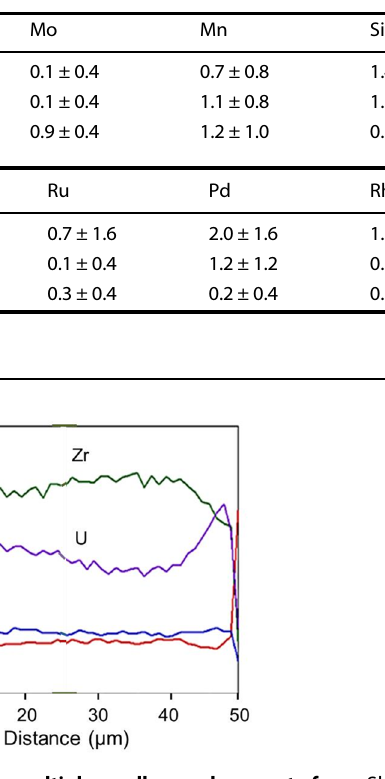
Table 2. Compositions of constituent phases in RAW-4, in at % a .